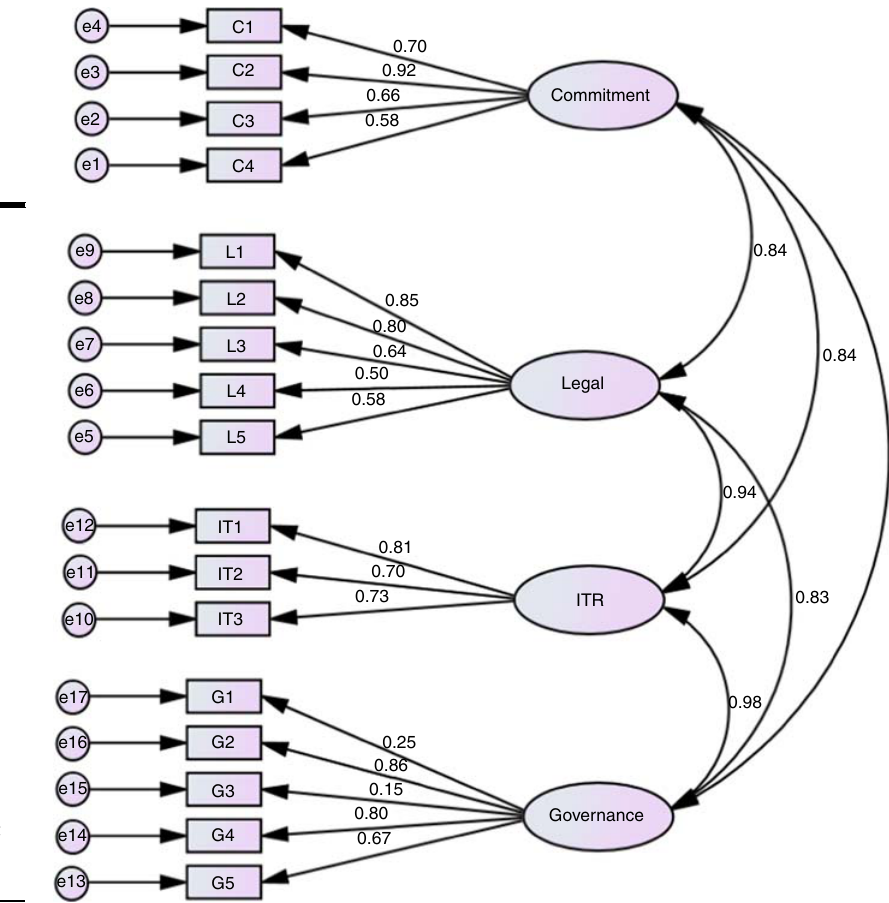
Figure 2. Initial measurement model and its factor